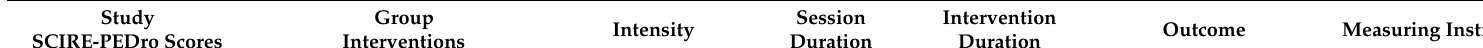
ASIA, LEMS RMT, MEP CCT, MUNE rigidity,